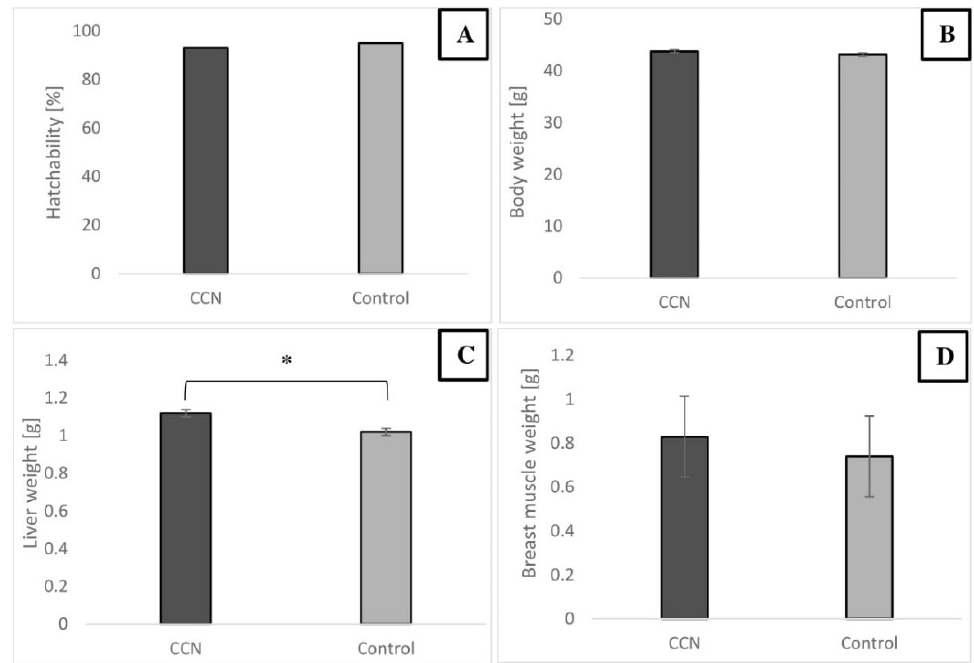
Figure 3. Hatchability ( A ), BW ( B ), liver weight ( C ), breast muscle weight ( D ) of chicken embryos on day 20 after IOI with 500 μ g/mL of CCN. * Value on bars differs significantly at p ≤ 0.05 . The error lines represent standard error of mean. Table 2. Serum parameters of chicken